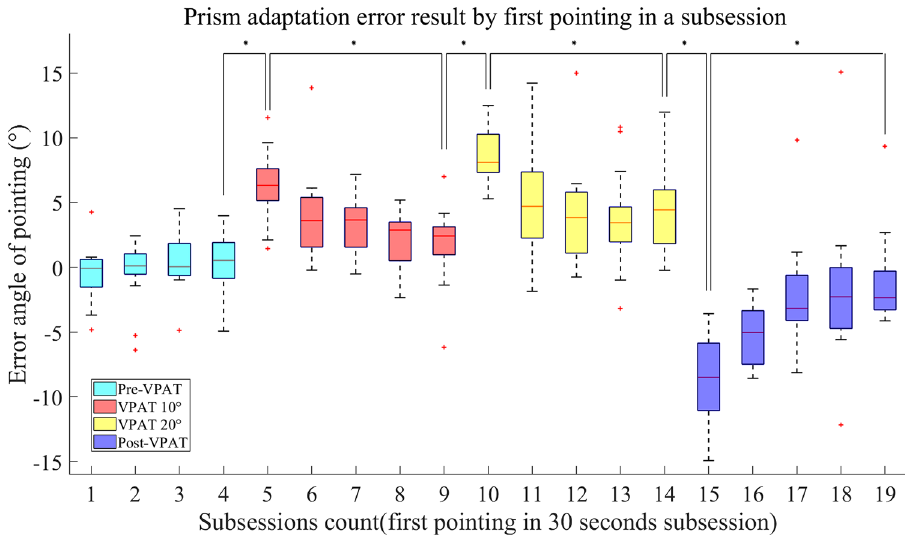
Figure 6. Pointing errors during the experiment. Positive value indicates rightward deviation, whereas negative value indicates leftward deviation. VPAT, virtual prism adaptation therapy. * p < 0.008 by Wilcoxon signed rank test with Bonferroni